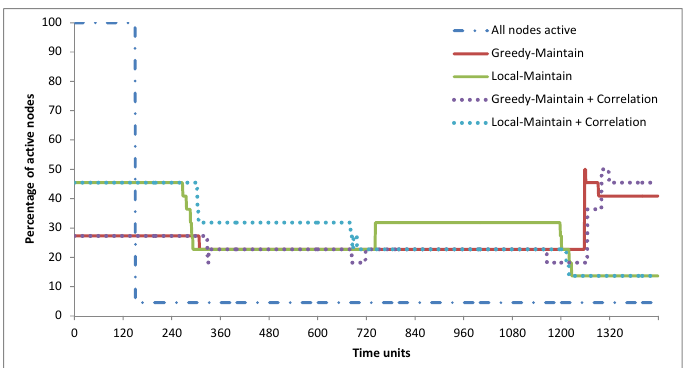
Figure 9. TMON’s global quality of coverage.